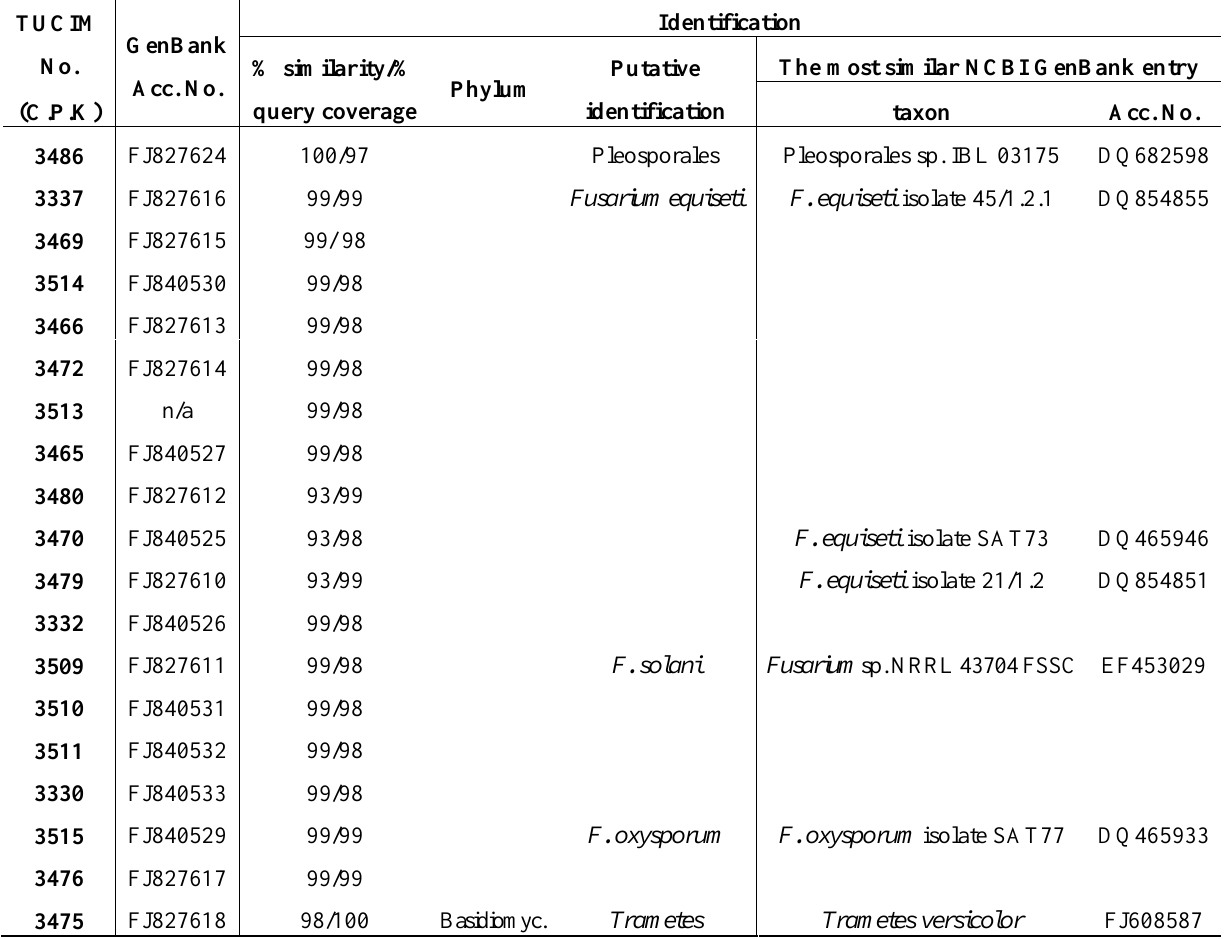
Table 2. Endophytic Trichoderma strains isolated from roots of C. arabica . TUCIM